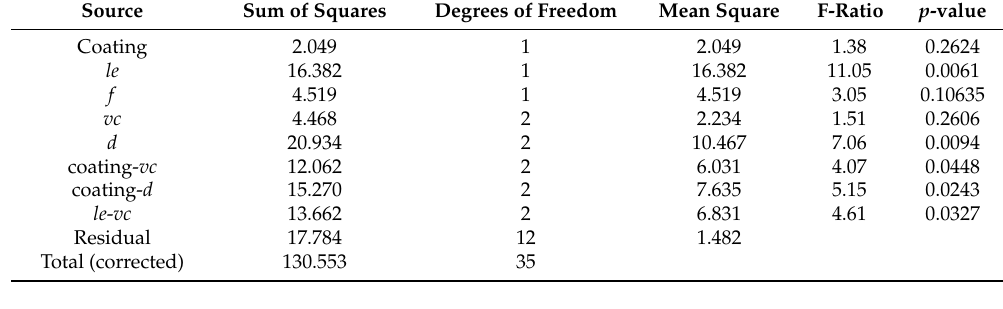
Energies 2015 , 8